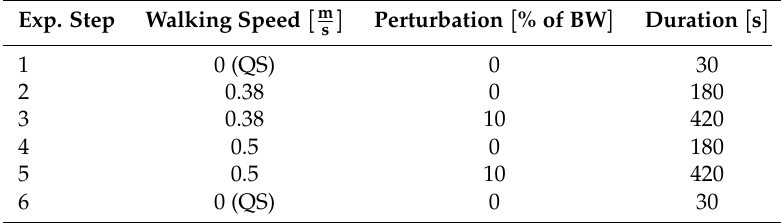
Table 2. Measurement protocol for stroke subjects. BW—body weight, QS—quiet standing. Exp.